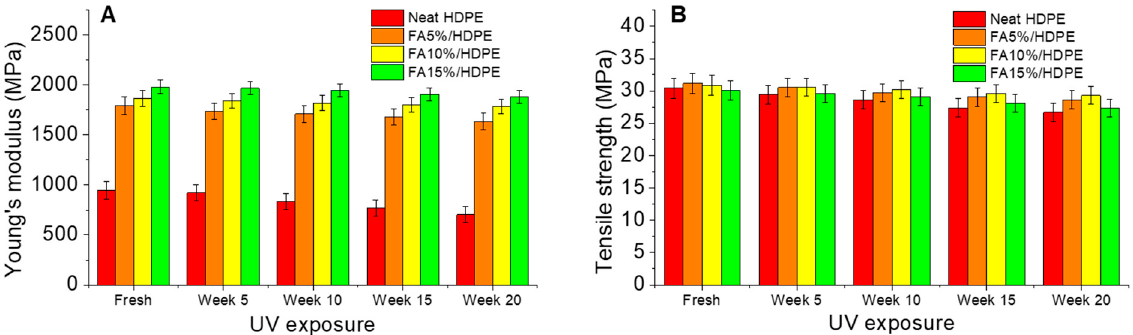
Figure 6. Tensile properties of neat HDPE and FA/HDPE samples evaluated before and after a few environmental ageing periods: ( A ) comparative Young’s modulus, ( B ) comparative tensile strength.